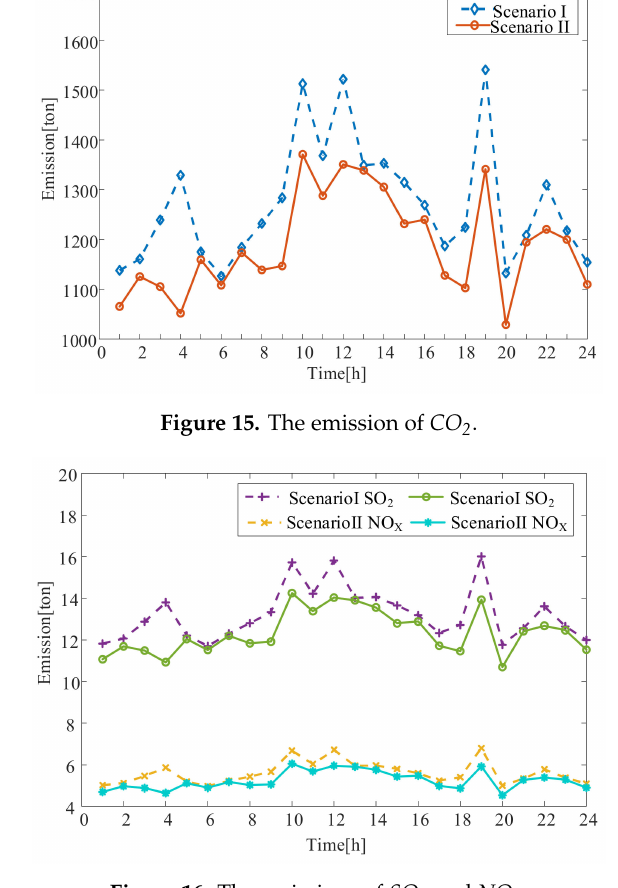
Figure 16. The emissions of SO 2 and NO x